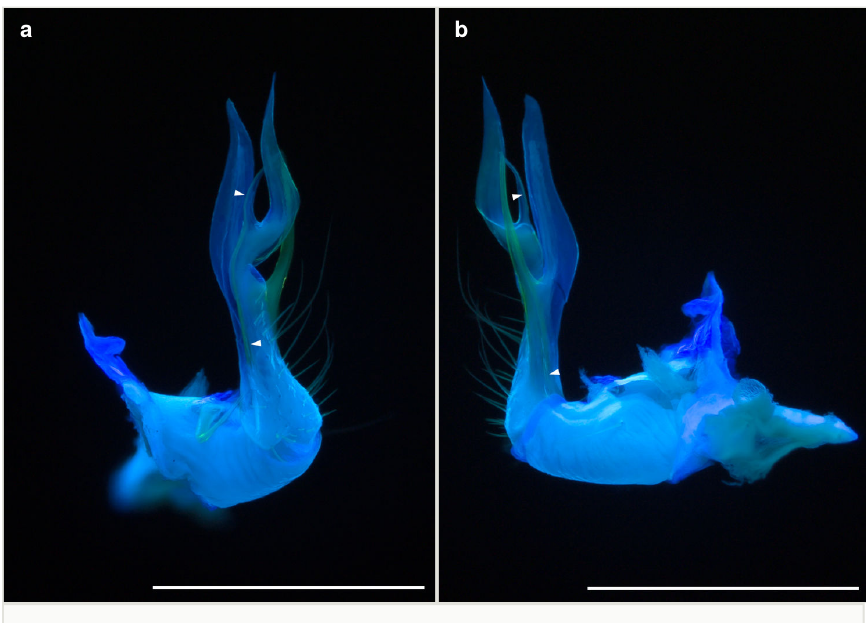
Figure 1. Fluorescent image of the left gonopod from a male Motyxia tularea tularea imaged in 350 nm UV light from a Canon 199A modi fi ed fl ash. Scale bars = 1 mm. Prostatic sperm groove labeled with